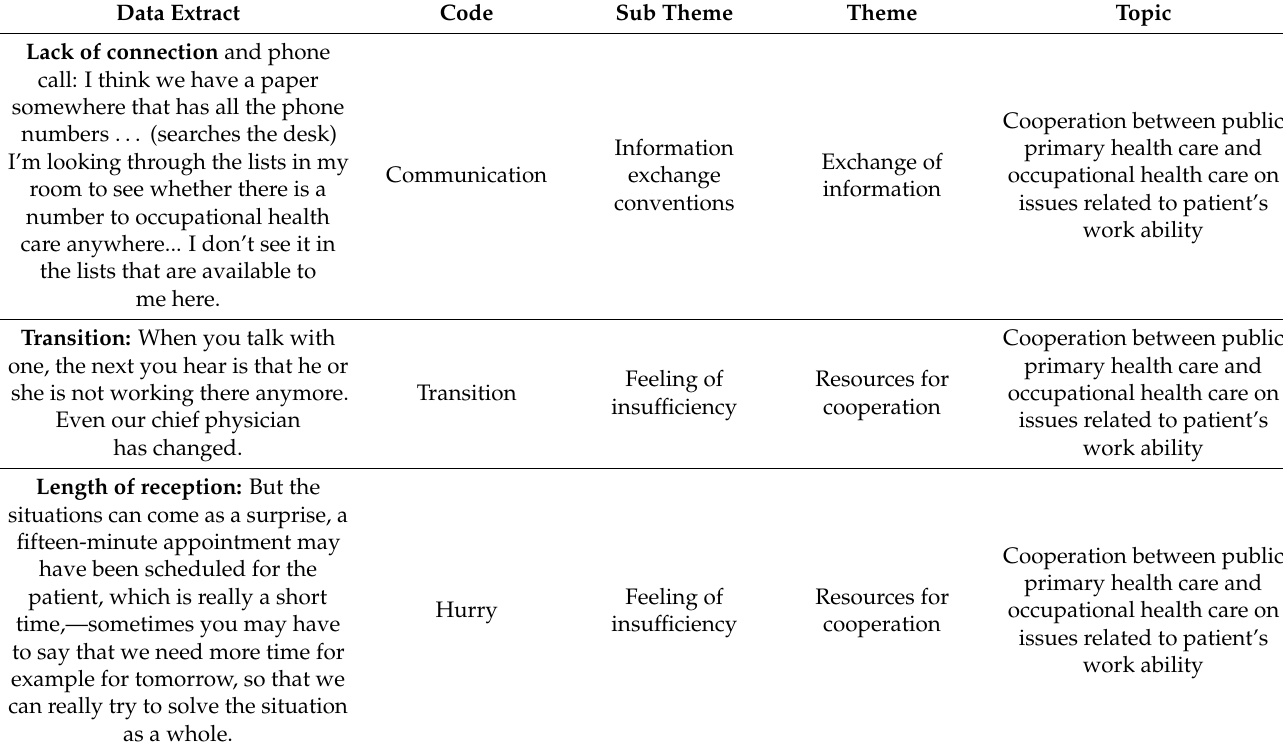
Table 2. An example of the analysis.